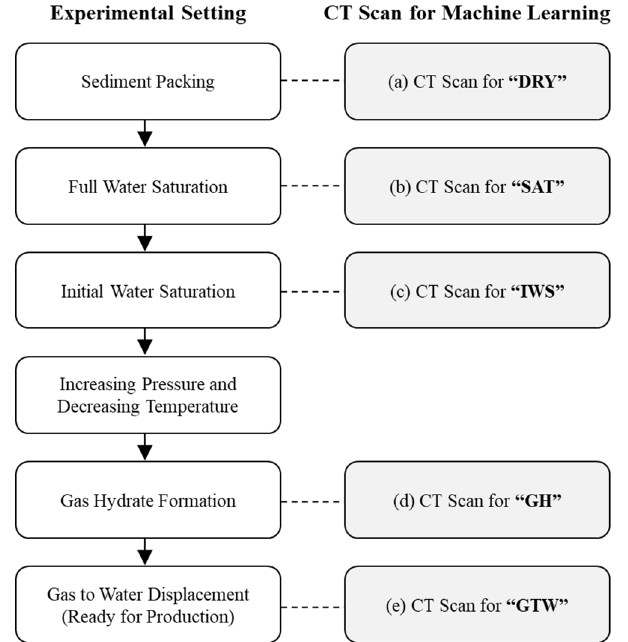
Figure 3. Flow chart of the GH formation experiment and CT scanning to obtain the training data for machine learning. ( a ) the first stage of the experiments to construct a sand sample; ( b ) the second stage to make a sample fully saturated with water; ( c ) the third stage with initial water and gas saturation; ( d ) the fourth stage to form gas hydrate by pressurization; ( e ) the fifth stage with only water and gas hydrate after replacement of gas by water.